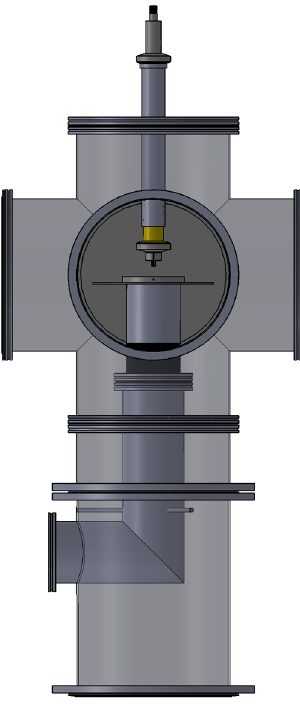
FIG. 3. Sketch of the scattering chamber details. The figure shows the inner piping of the LF250 scattering chamber, the top part of the inner pipe is the catcher. It is connected to a threaded LF100 flange in its middle section for varying the distance to the nozzle. A table can be attached to it for placing detectors